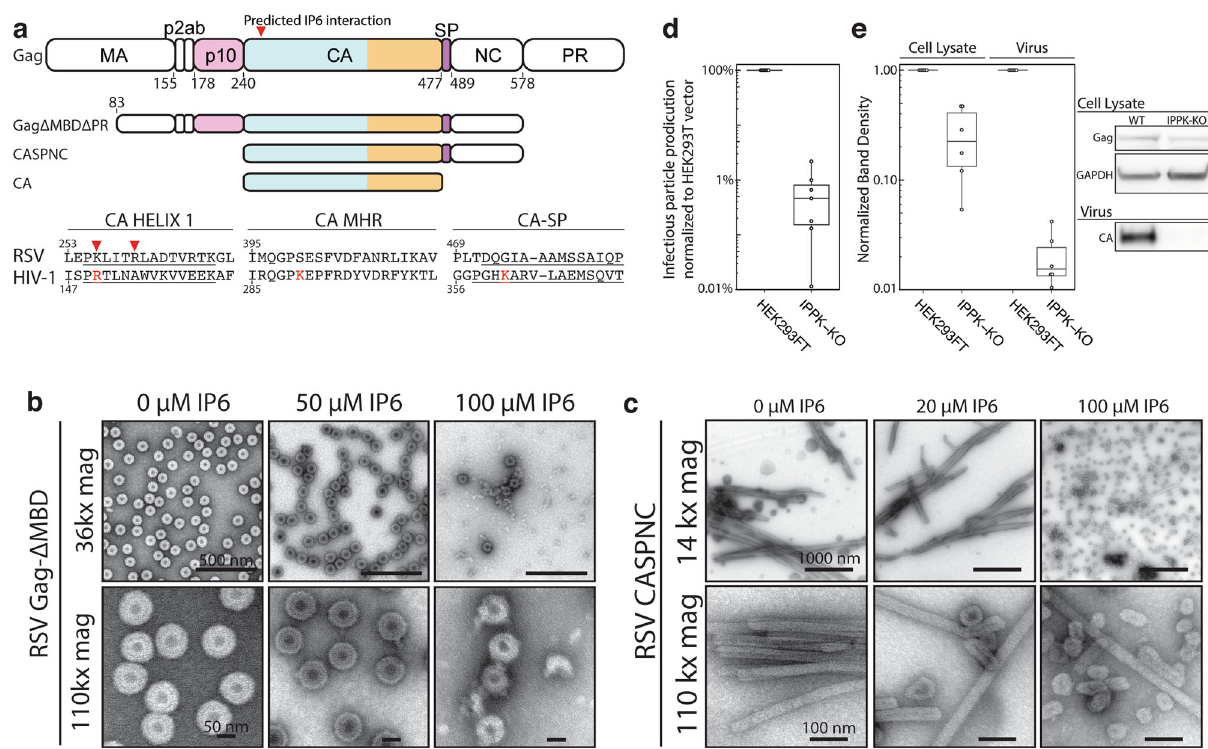
Fig. 1 Effect of IP6 on RSV in vitro and in cells. a RSV Gag and truncation proteins used for assembly and structure determination. Alignment of RSV and HIV-1 amino acid sequences. Known HIV-1 IP6-interacting residues shown in red and predicted RSV IP6-interacting residues indicated (red arrow). b TEM images of immature RSV Gag- Δ MBD assembly without and with IP6 at low and high magni fi cation. c TEM images of mature RSV CASPNC assembly without and with IP6 at low and high magni fi cation. d RSV infectious virus particle production in wild type (HEK293T) and IPPK-KO cell lines. e (left) Western blot normalized band intensity, and (right) representative western blots of of cell lysate and GAPDH control (top) and virus fractions (bottom). Uncropped western blots are shown in Supplementary Fig. 1. Box plots: center lines show the medians, box limits indicate the 25th and 75th percentile; whiskers extend to minimum and maximum values; data points are plotted as circles. Source data are provided with this